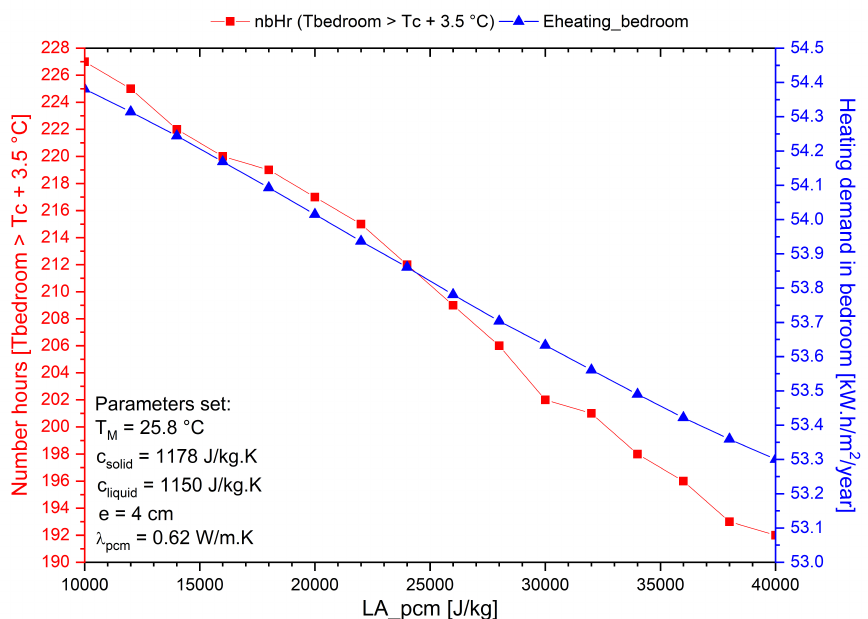
Figure 12. Number of hours of thermal discomfort and heating demand vs. latent heat during the cold season (7 months total: January–April and